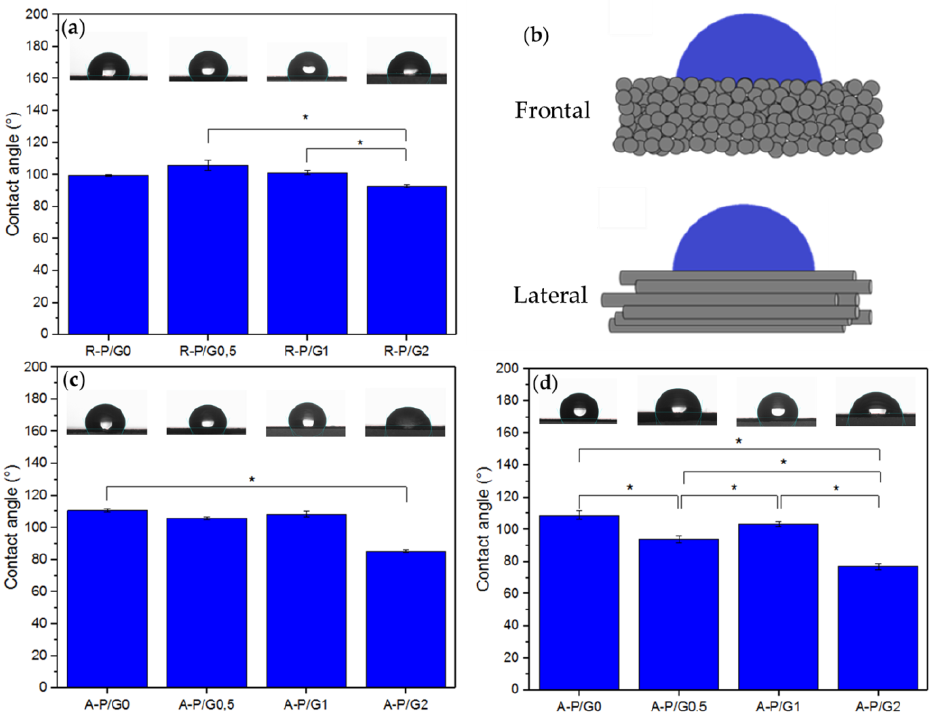
Figure 4. The static water CA. ( a ) R‑P/G‑EPnF, ( b ) schematic representing the different ways of measuring CA on an anisotropic surface, ( c ) A‑P/G‑EPnF obtained frontal to the fibers, and ( d ) A‑ P/G‑EPnF obtained lateral to the fibers. Asterisk (*) indicates p <